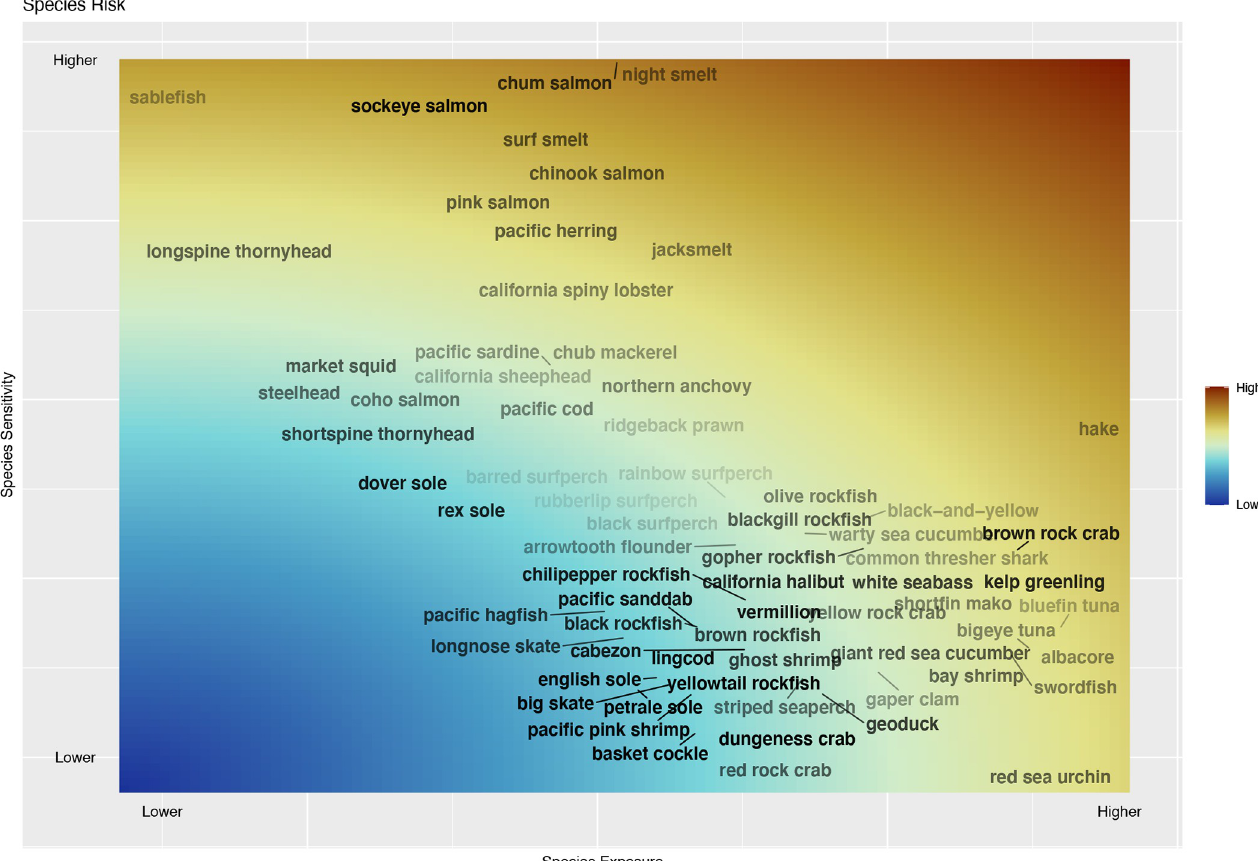
Fig 2. Ecological exposure and ecological sensitivity to climate changes for fisheries species. Ecological risk to climate change (changes in pH, temperature, chlorophyll, and oxygen) which is the Euclidean distance between ecological exposure and ecological sensitivity. Ecological exposure and sensitivity are averaged across the four climate variables (each ranging from 0 to 1) for each climate model and then averaged across three climate models for species in top 90% of landings (by weight) for US West Coast fishing communities. See S2 Table for individual species risk. Transparency of the name corresponds to standard deviation in exposure (more transparent equals higher deviation/uncertainty) across the three climate models (relative to the other species groups).